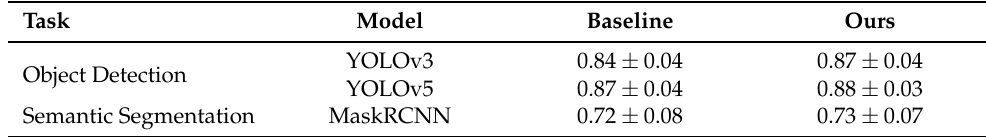
Table 5. Validation of position attention block’s generality based on object detection and semantic segmentation